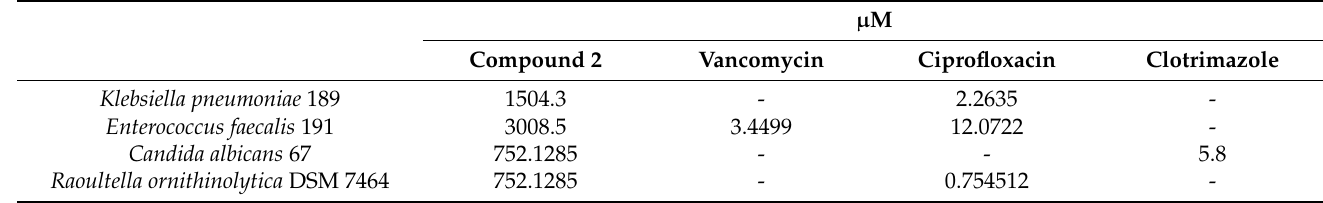
Table 2. MIC value ( µ M) of compound against bacterial